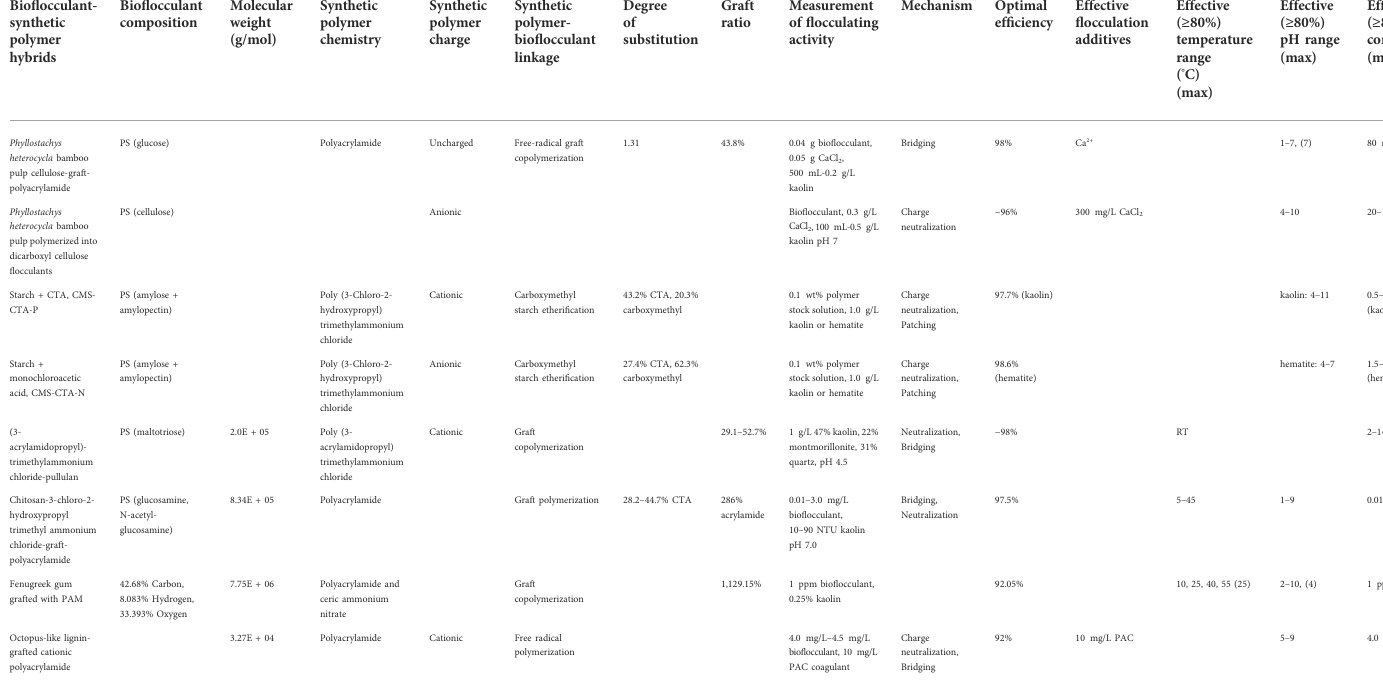
TABLE 5 Chemically modi fi ed bio fl occulants and their fl occulation performance. Bio fl occulant-